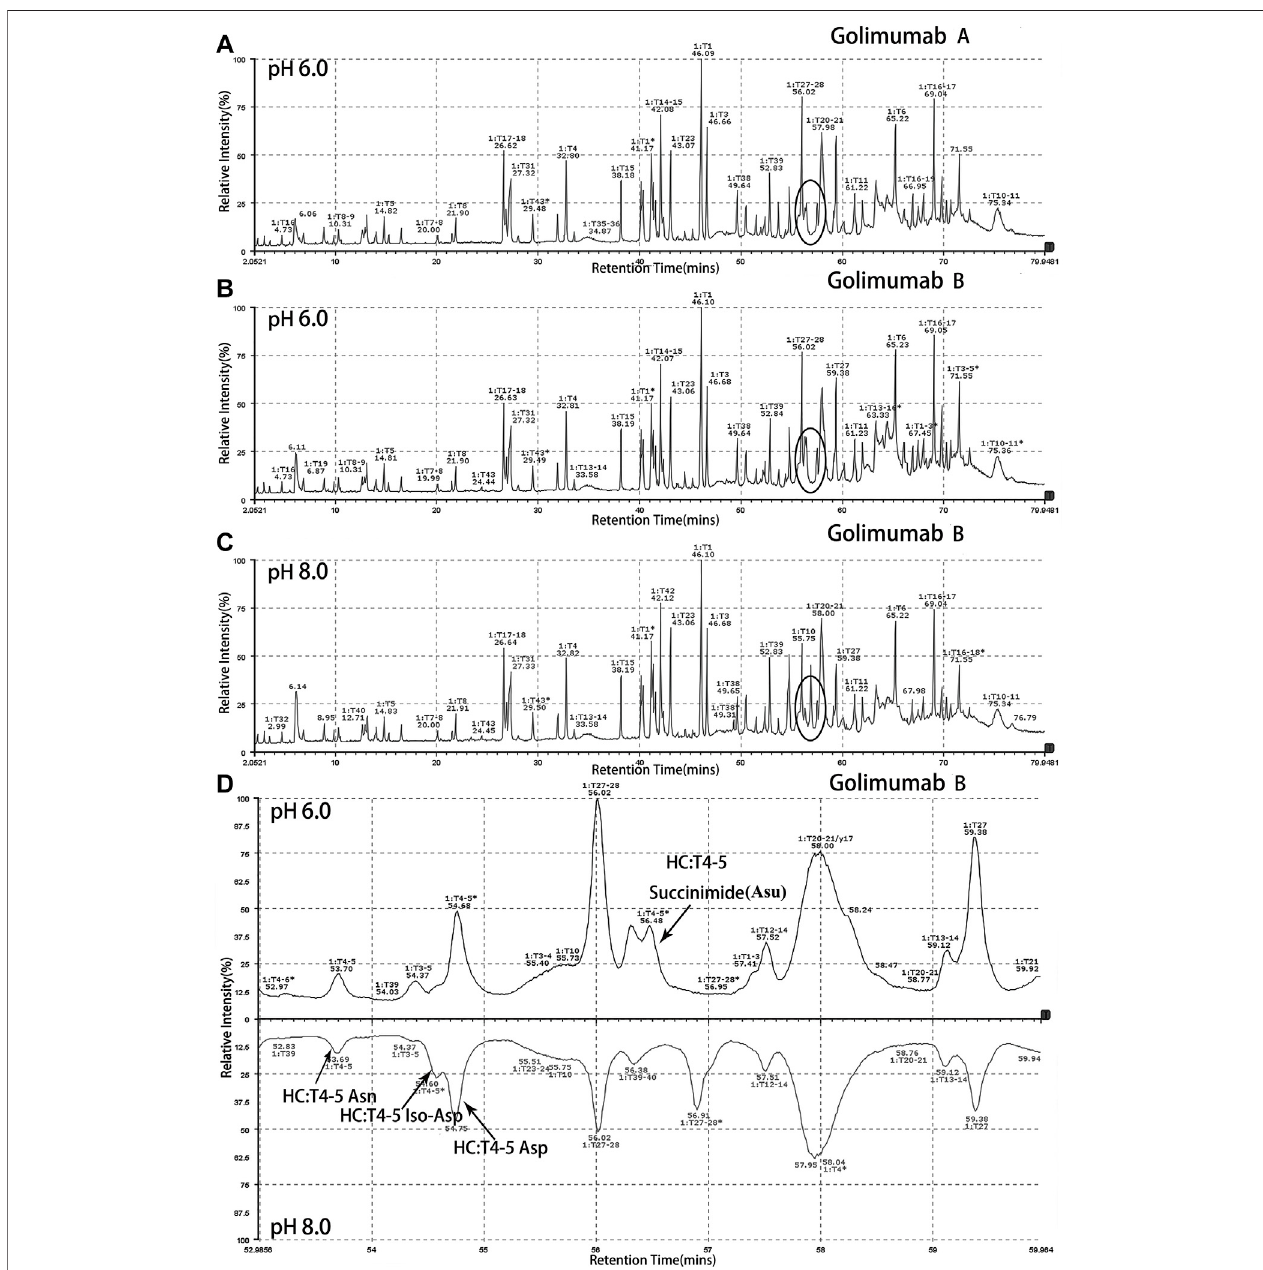
FIGURE 4 | Identi fi cation and characterization of the unexpected peak by the peptide-based MAM. An unexpected peak eluting at about 56.5 min was detected [ (A) : golimumab A pH 6.0, (B) : golimumab B pH 6.0, (C) : golimumab B pH 8.0, and (D) : comparison of golimuamb B at pH 6.0 and pH 8.0].